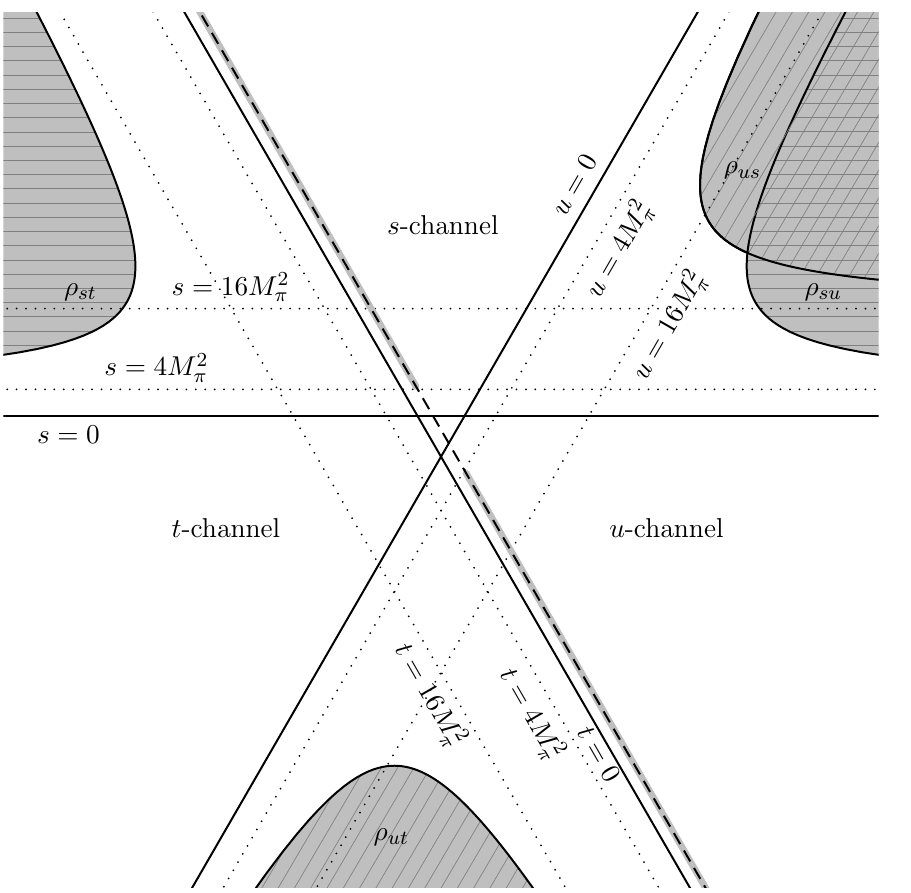
Figure 7. Mandelstam diagram for HLbL scattering for the case q 2 Only those double-spectral regions for \2disc"-box topologies are shown that are reconstructed from the (cid:12)xed- t dispersion relation. The dashed line marks a line of (cid:12)xed t with its s - and u -channel cuts highlighted in